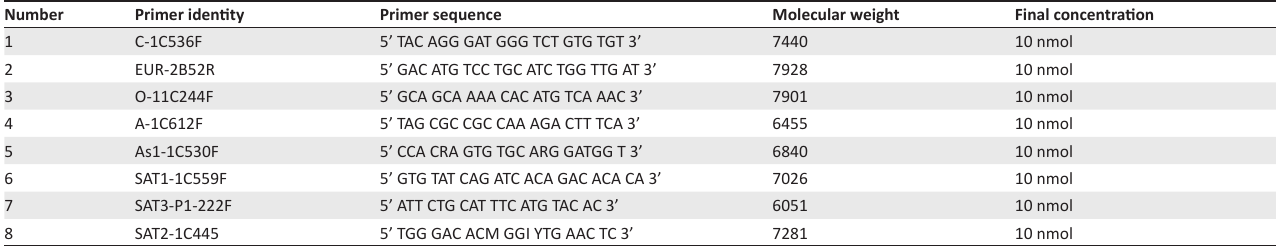
TABLE 1: Detailed information of the virus protein 1 primers used in the study.